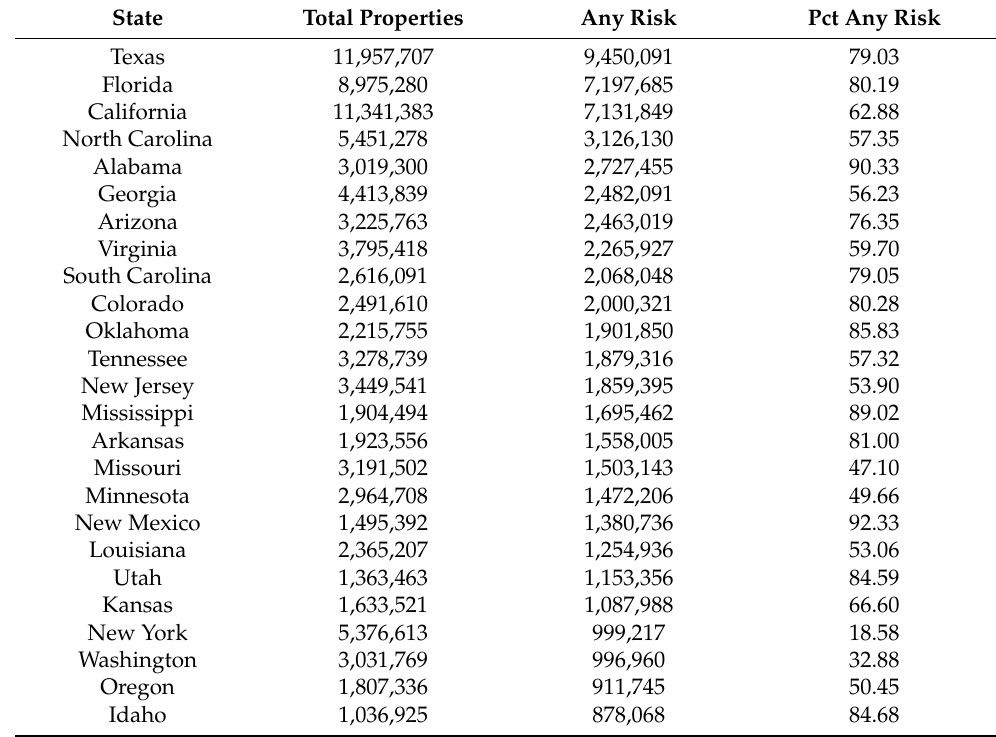
Table 3. Top 25 state ranking by “any risk” (cumulative burn probability of >1%).